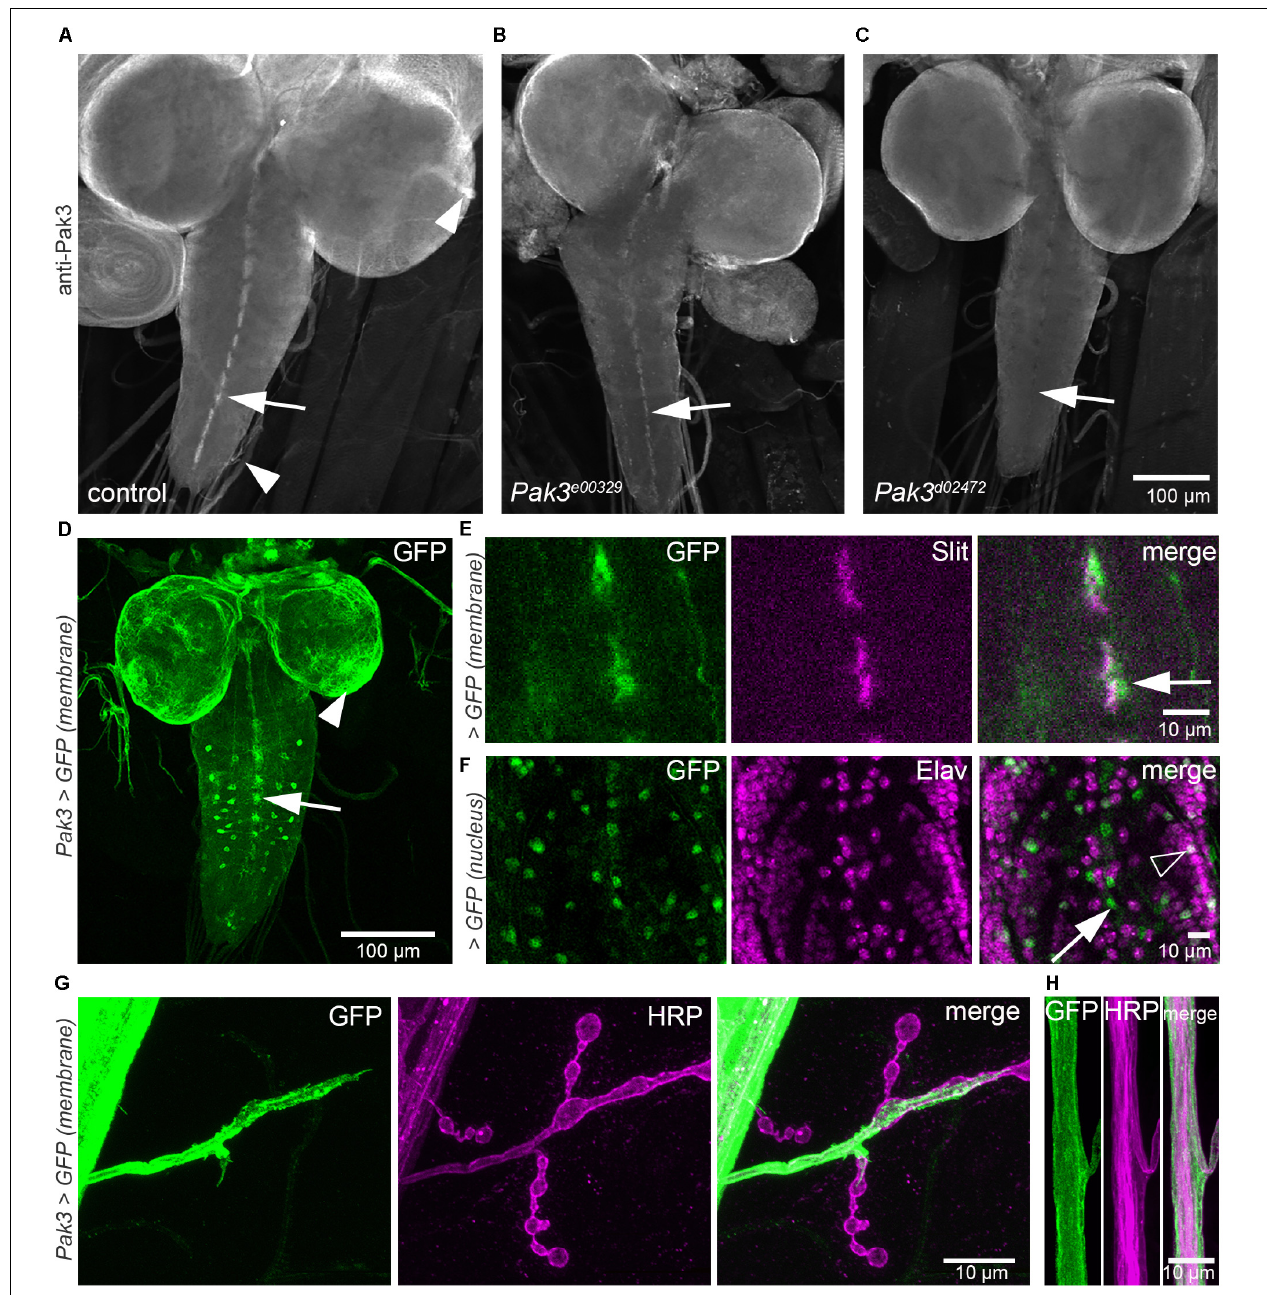
FIGURE 1 | Pak3 is expressed in larval glia. (A–C) An anti-Pak3 polyclonal antibody reveals immunostaining consistent with glial cell expression: in larval ventral nerve cord (VNC) midline cells ( A , arrow), along axonal projections emanating from the brain and VNC ( A , arrowheads), and on the surface of the CNS. Expression is reduced in Pak3 e 00329 mutants (B) and almost undetectable in Pak3 d 02472 mutants (C) , consistent with the severity of RNA disruption in these alleles and thus supporting antibody specificity. (D) A second method of observing Pak3 expression using the GAL4-UAS reporter system, Pak3-GAL4 NP 4472 > UAS-mcD8::GFP , shows similar membrane GFP expression patterns (midline cells, arrow; surface cells, arrowhead), with additional cells visible in the VNC. (E) Midline membrane GFP expression (green) overlaps with anti-Slit (magenta; arrow), a marker for midline glia from embryonic through larval stages (Oliva et al., 2016). (F) Expression of nuclear-localized GFP (green) in animals with Pak3-GAL4 NP 4472 > UAS-nls::GFP confirms that the midline cells are anti-Elav-negative, indicating non-neuronal identity (arrow), but other GFP-positive cells in the VNC are neuronal (open arrowhead). (G,H) Along motor axons and at neuromuscular junction (NMJ) synapses, strong membrane GFP expression (green) extends beyond regions staining with the neuronal marker HRP (magenta), appearing to wrap the axons as well as project over proximal synaptic boutons, consistent with Pak3 expression in peripheral glia.